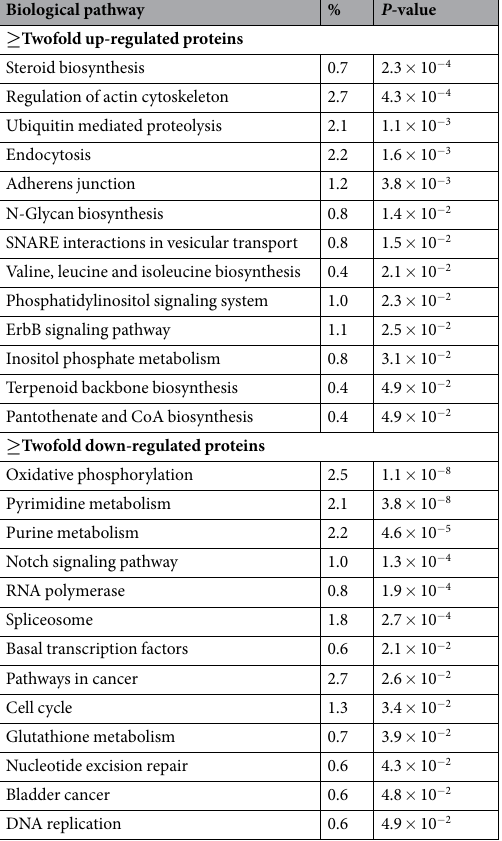
Table 2. Main enzymatic and metabolic pathways associated with the up-regulated and down-regulated proteins in ganetespib-treated 5637 cells as analyzed by the Kyoto Encyclopedia of Genes and Genomes